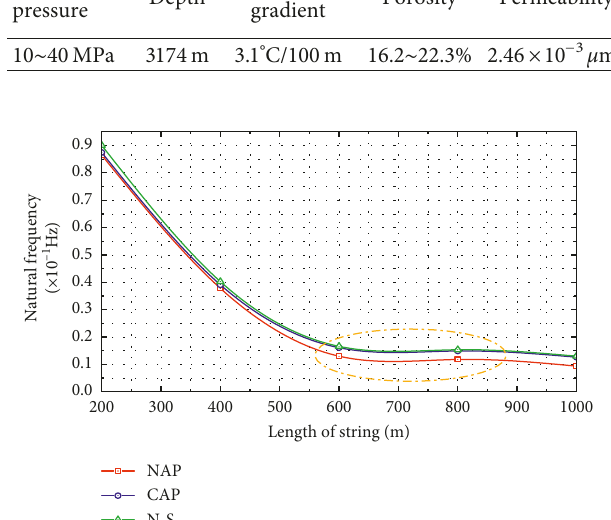
Figure 3: Curve of relationship between length and natural fre- quency for two